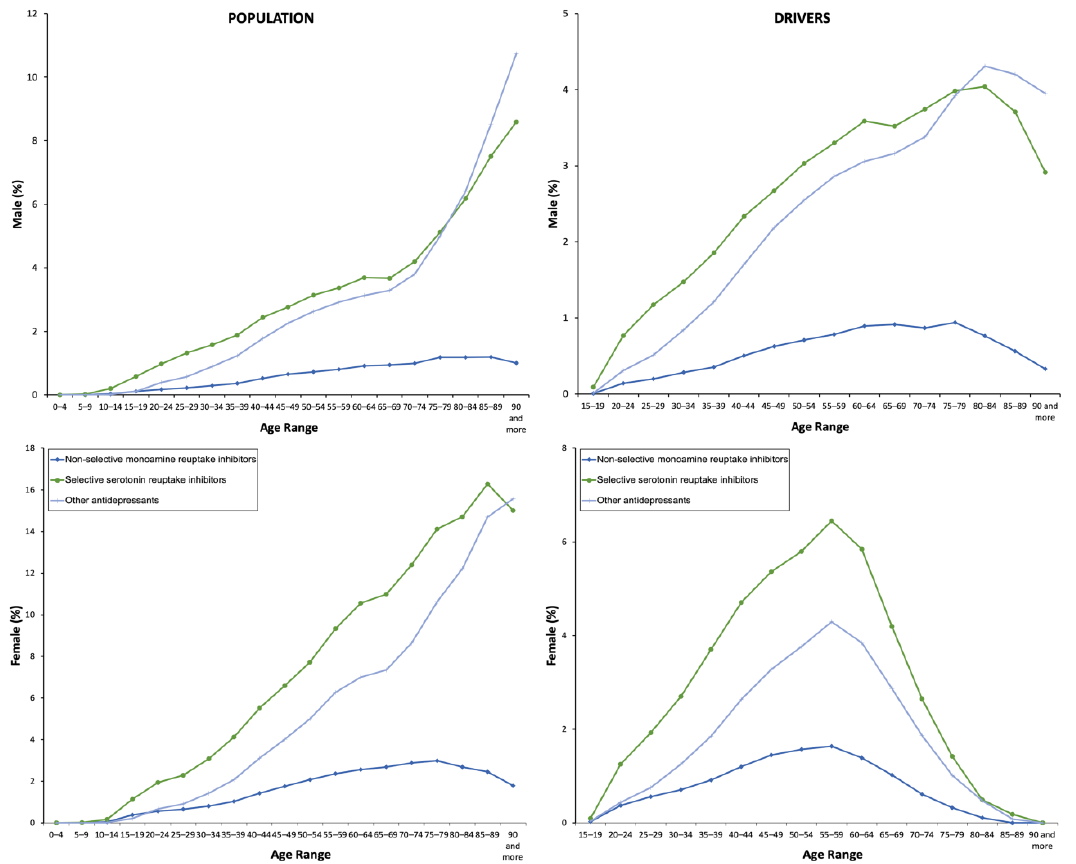
Figure 2. Frequency of use by the type of antidepressant.